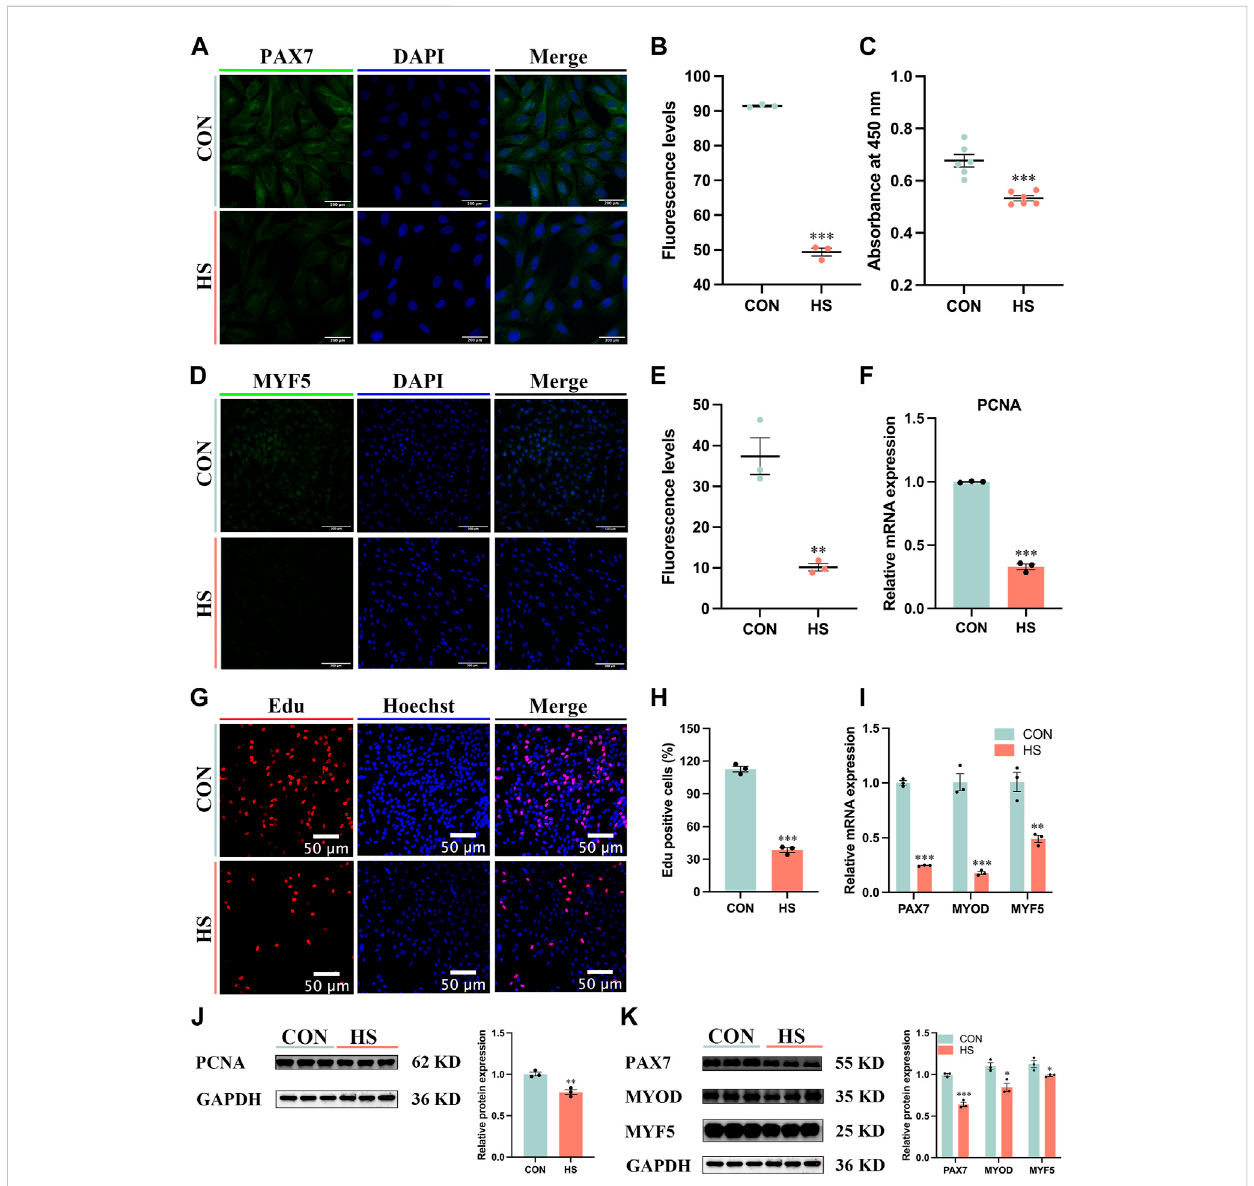
FIGURE 2 Heat stress inhibited the proliferation of myoblasts. Representative images of (A) PAX7, Scale bar, 200 μ m, and (D) MYF5 by immuno fl uorescence in myoblasts at proliferation. Scale bar, 500 μ m. The fl uorescence levels of PAX7 (B) and MYF5 (E) in myoblasts at proliferation. (C) The cell viability of myoblasts wasdetected byCCK8.mRNA (F) andprotein (J) expressionofPCNAinmyoblasts atproliferation. (G) Eduassay detectedthecellproliferation of myoblasts. Scale bar, 50 μ m. (H) The Edu-positive cells of myoblasts. mRNA (I) and protein (K) expression of PAX7, MYOD and MYF5 in myoblasts at proliferation. All data are shown as the mean ± SEM (n = 3, * p < 0.05; ** p < 0.01, *** p <